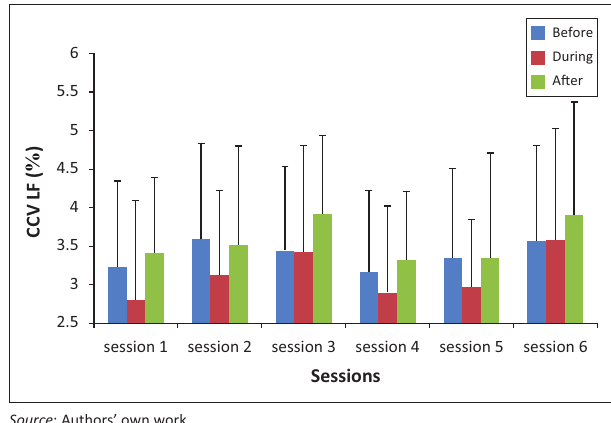
FIGURE 3: CCV for LF before, during and after therapeutic horseback riding (THR) over six